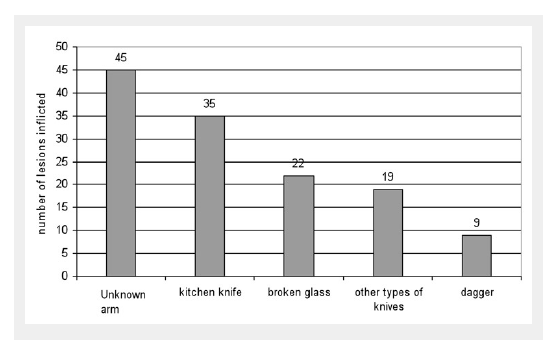
Number of injuries inflicted according to the type of weapon, in our cohort of 80 consecutive stab